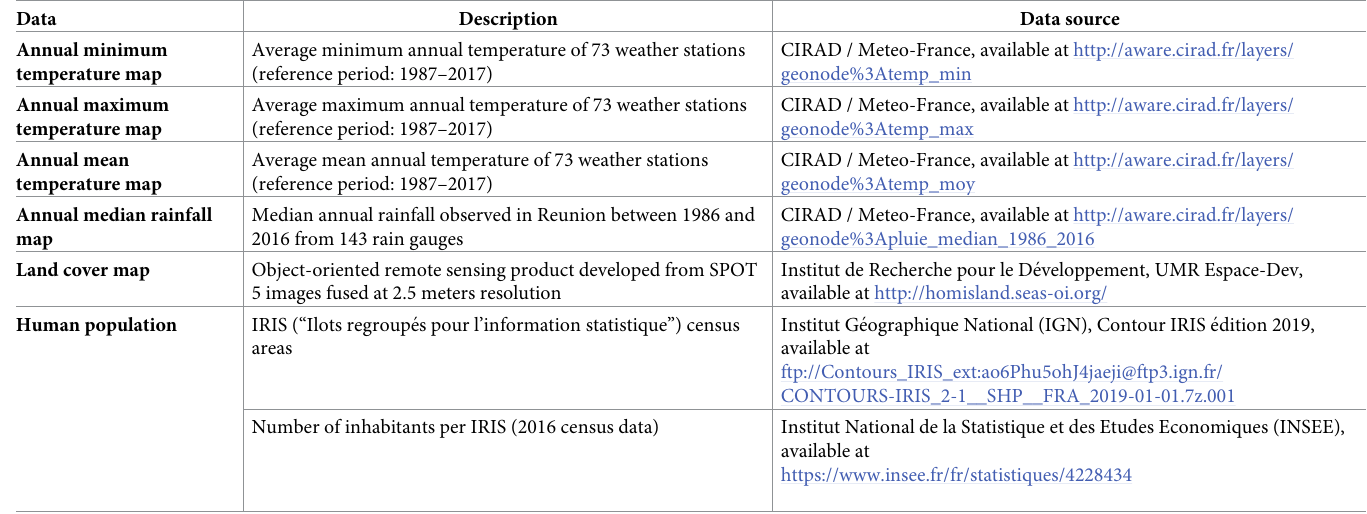
Table 1. Sources of geographic